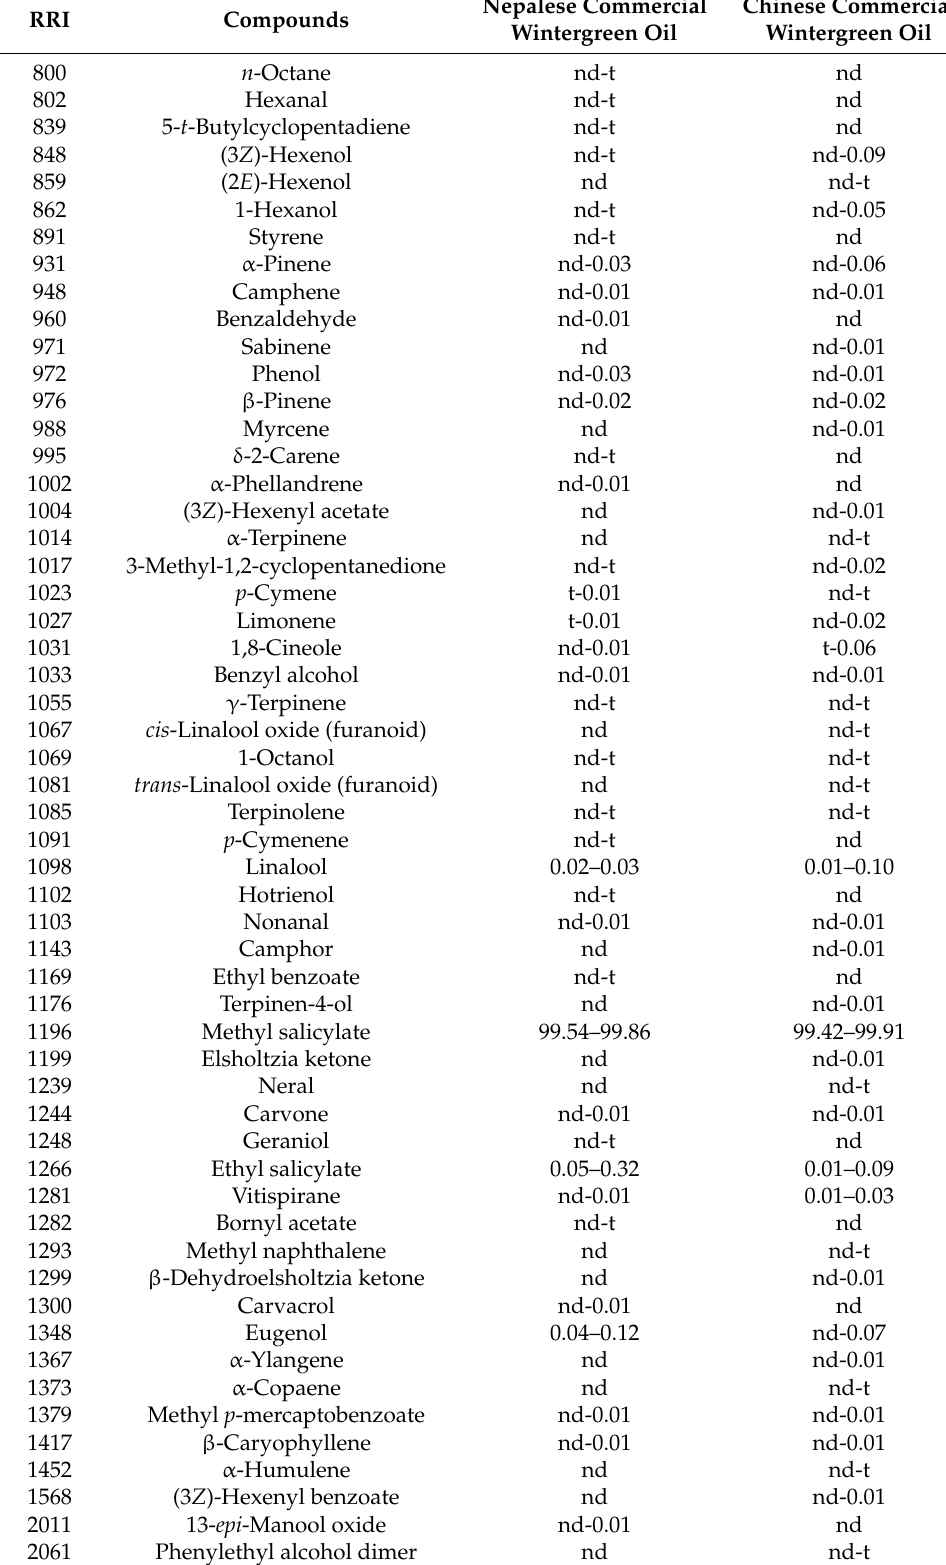
Table 5. Comparison of Nepalese and Chinese commercial wintergreen oils; “nd” indicates not detected and “t” indicates trace